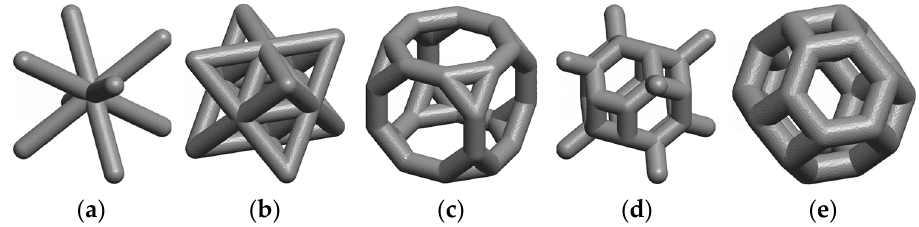
Figure 1 . Different types of lattice-frame materials with the same thickness of 2.0 mm: ( a ) Body- centered cubic (BCC); ( b ) Octet; ( c ) Truncated cube; ( d ) Truncated octahedron; ( e ) Kelvin cell.